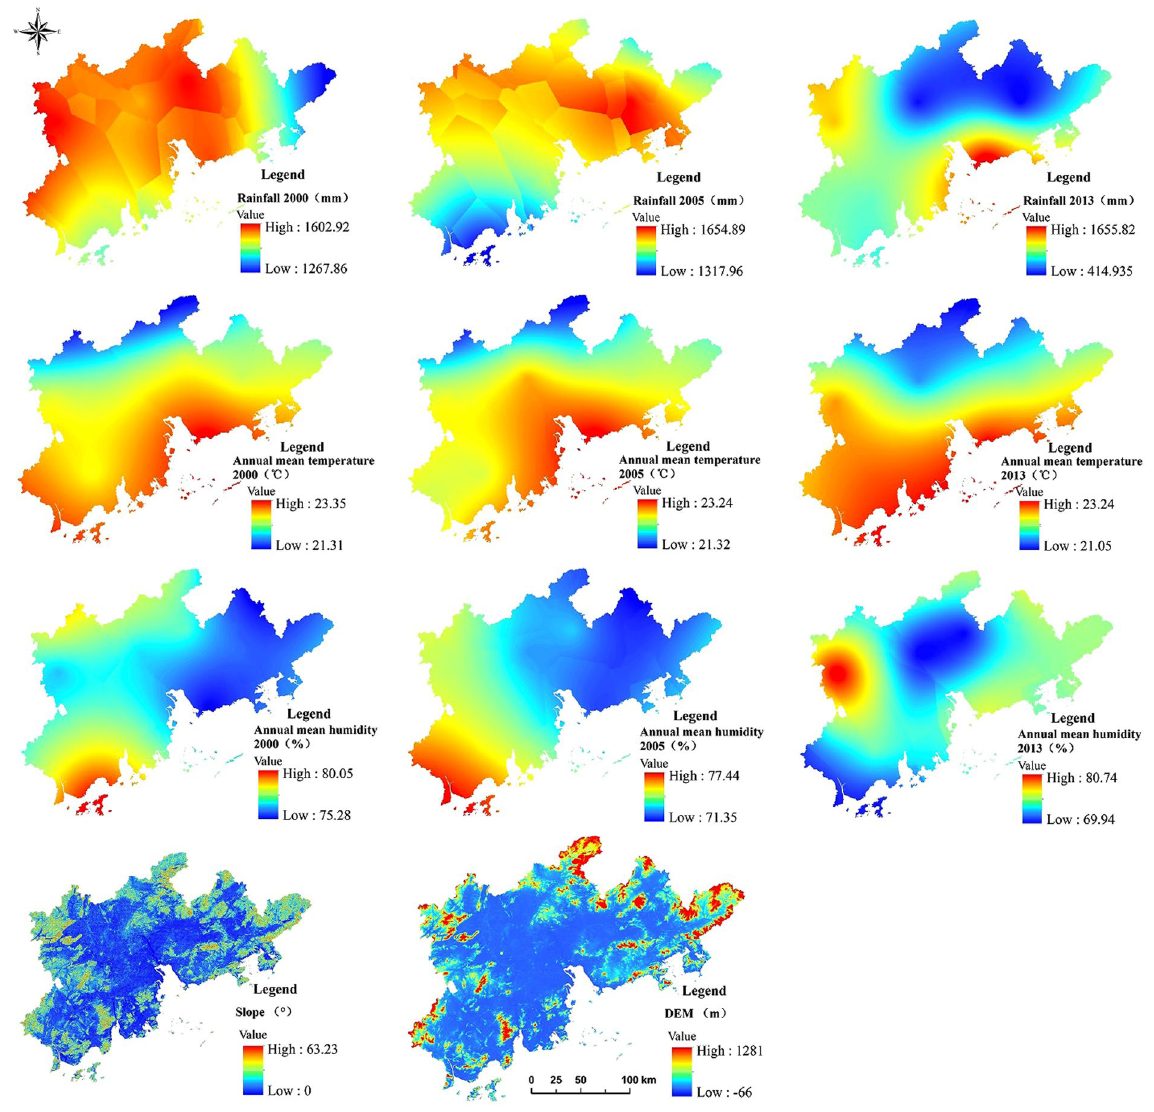
Figure 4. Natural conditions in the Pearl River Delta area. Map created using ArcMap (version 10.2) software from Esri (http://www.arcgis.com/).